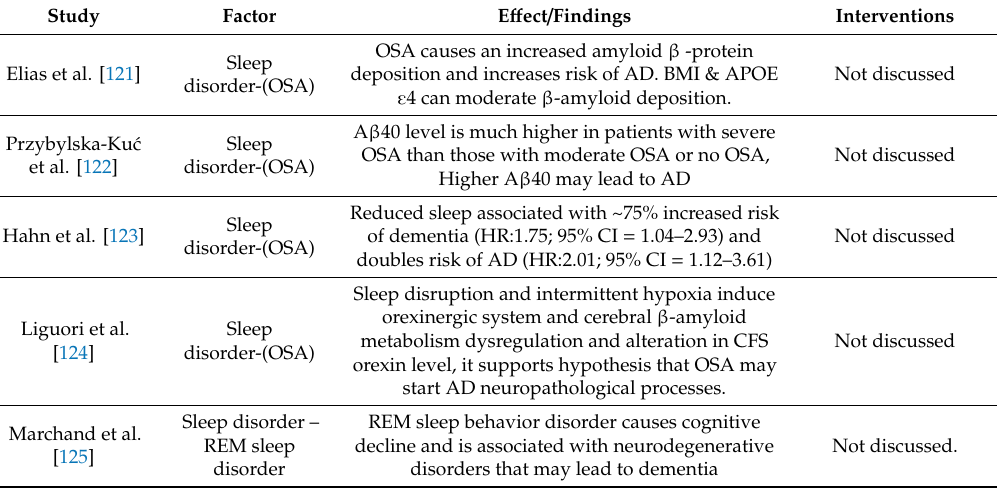
Table 6. Studies associating sleep disorder with dementia and Alzheimer’s